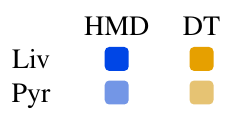
Figure 1. 3D Visualizations. Each row represents a model and each column its visualization along an axis. The latter is displayed according to the following axes, from left to right: +x, +y, in blue (#4e79a7), hepatic artery in red (#e15759), hepatic vein or venous system in teal (#76b7b2). (Bottom) Pyramid: pyramid tip or pyramidion in teal, internal chambers in red, surface features (i.e., two cracks and entrance) in blue. The common encodings are: surface in light gray (#bab0ac), sphere in yellow (#edc948). To better perceive internal structures, surface opacity is set to 0.5 and the sphere is highlighted by a white